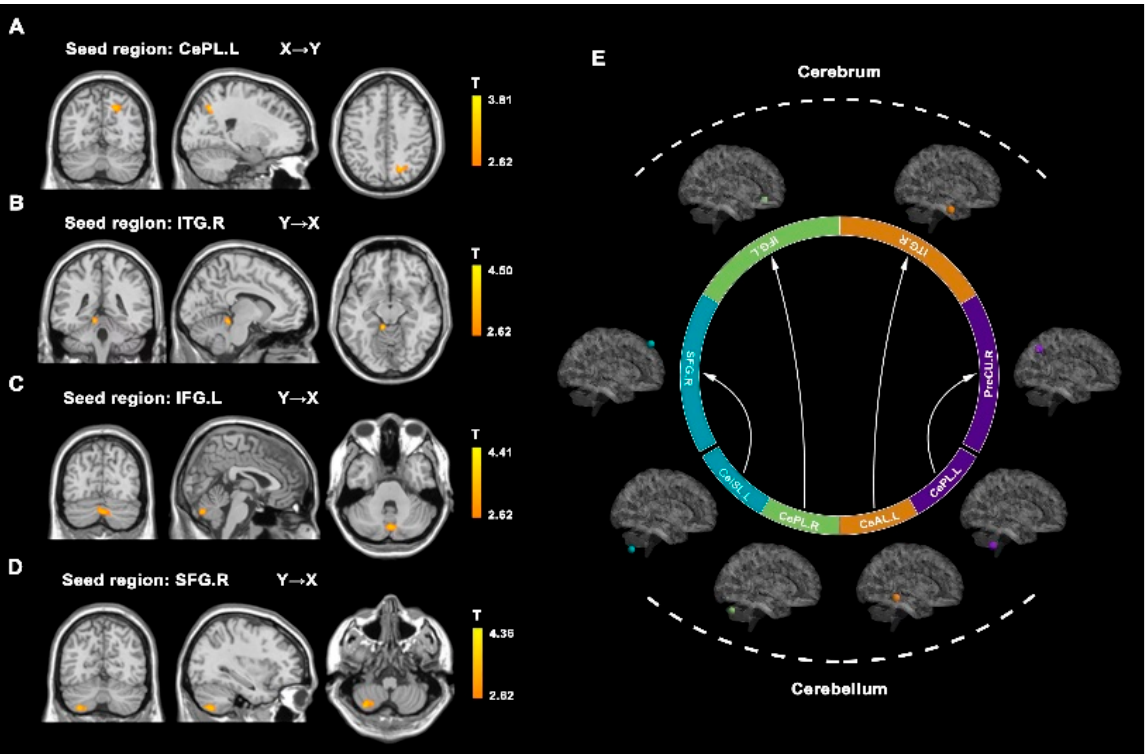
Figure 2. Aberrant effective connectivity in juvenile myoclonic epilepsy (JME) patients. ( A ) Increased effective connectivity from the left cerebellum posterior lobe (CePL.L) to the right precuneus (PreCU.R; p < 0.01, AlphaSim-corrected). ( B ) Increased effective connectivity from the left cerebellum anterior lobe (CeAL.L) to the right inferior temporal gyrus (ITG.R; p < 0.01, AlphaSim-corrected). ( C ) Increased effective connectivity from the right cerebellum posterior lobe (CePL.R) to the left inferior frontal gyrus (IFG.L; p < 0.01, AlphaSim-corrected). ( D ) Increased effective connectivity from the left inferior semi-lunar lobule of cerebellum (CeISL.L) to the right superior frontal gyrus (SFG.R; p < 0.01, AlphaSim-corrected). ( E ) Summary of the increased effective connectivity and spatial distribution from the cerebellum to the cerebrum. Table 3. Brain areas showing significant differences in EC between patients with JME and HCs.